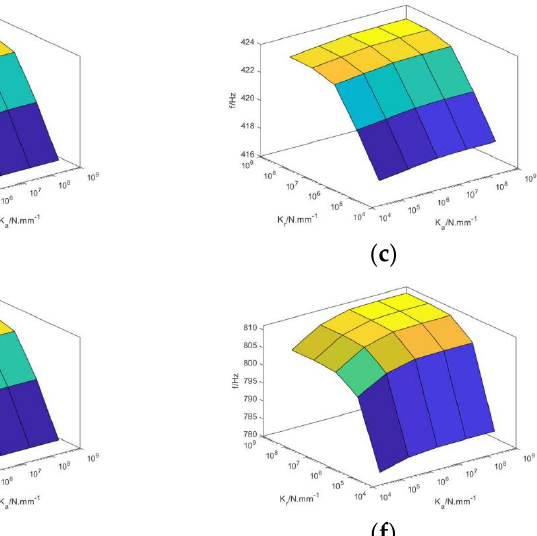
Table 4. First six-order natural frequencies of the turntable at different swing angles.